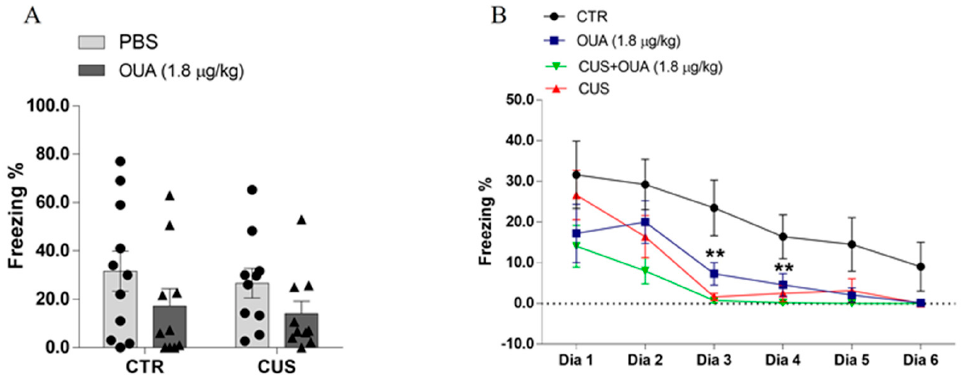
Figure 8. The effects of chronic ouabain administration and chronic unpredictable stress in the formation and extinction of fear memory. ( A ) Shows that there was no difference in the freezing percentage between the groups studied, 24 h after foot shock in the animals of the different groups ( n = 10) (F (1, 37) = 0.3469; p = 0.5595 for CUS factor. F (1, 37) = 3.840; p = 0.0576 for treatment factor). ( B ) Animals from control group (CTR) ( n = 10) presented higher percentage of freezing on days 3 (F (1, 37) = 12.94; p = 0.0009 for CUS factor. F (1, 37) = 4.663; p = 0.0374 for treatment factor) and 4 (F (1, 37) = 7.477; p = 0.0095 for CUS factor. F (1, 37) = 4.443; p = 0.0419 for treatment factor), compared to OUA ( n = 10), CUS ( n = 10), and CUS + OUA ( n = 10) groups. Data are presented as mean ± SEM. ** p < 0.01 when compared with CTR-PBS x OUA; CTR-PBS x CUS; and CTR-PBS x CUS + OUA (t-student test was performed or a two-way ANOVA, followed by Newman– Keuls post hoc test, revealed a